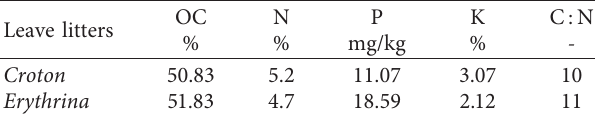
Table 1: Chemical characteristics of organic nutrient